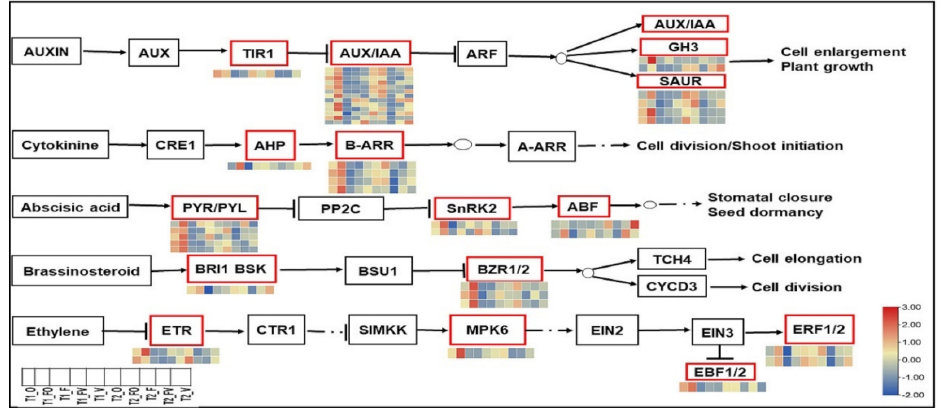
Figure 6. Diagram charts of plant hormone signal transduction pathway supported by heatmap analysis of normalized expression data in B. napus hybrids (FO and FV) and their parents. AUX1; Auxin1, TIR1: Transport inhibitor response 1, GH3: Gretchen Hagen 3, AUX/IAA: Auxin/indoleacetic acid, SAUR: Small auxin − up − regulated RNA, CRE1: Cytokinin receptor, AHP: Histidine − containing phosphotransfer protein, B − ARR: Type B − Arabidopsis response regulator, A − ARR: Type A − Arabidopsis response regulator, PYR: Pyrabactin resistance, PYL: PYR − Like, PP2C: Protein phosphatase 2C, SnRK2: Sucrose non − fermenting − 1 − related protein kinase2, ABF: